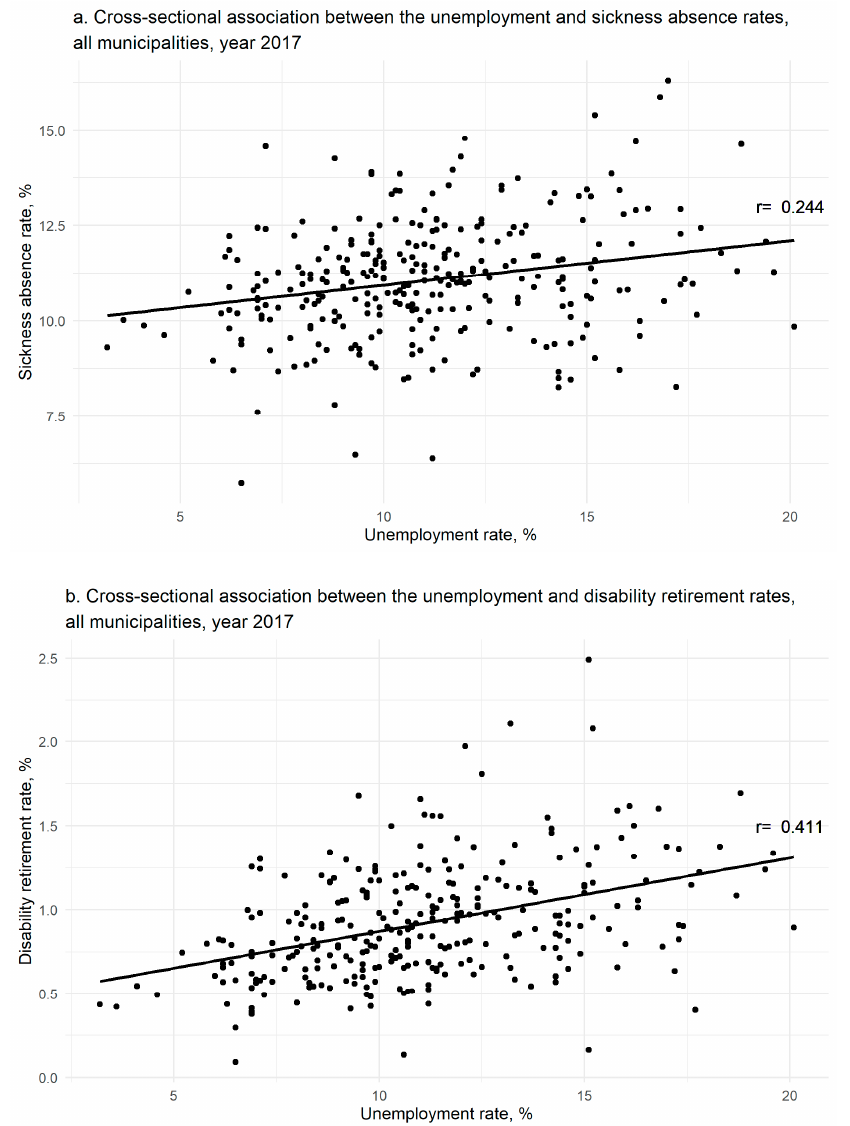
Figure A2. Cross-sectional associations of municipality-level unemployment rate with ( a ) sickness absence rate and ( b ) disability retirement rate in 2017.